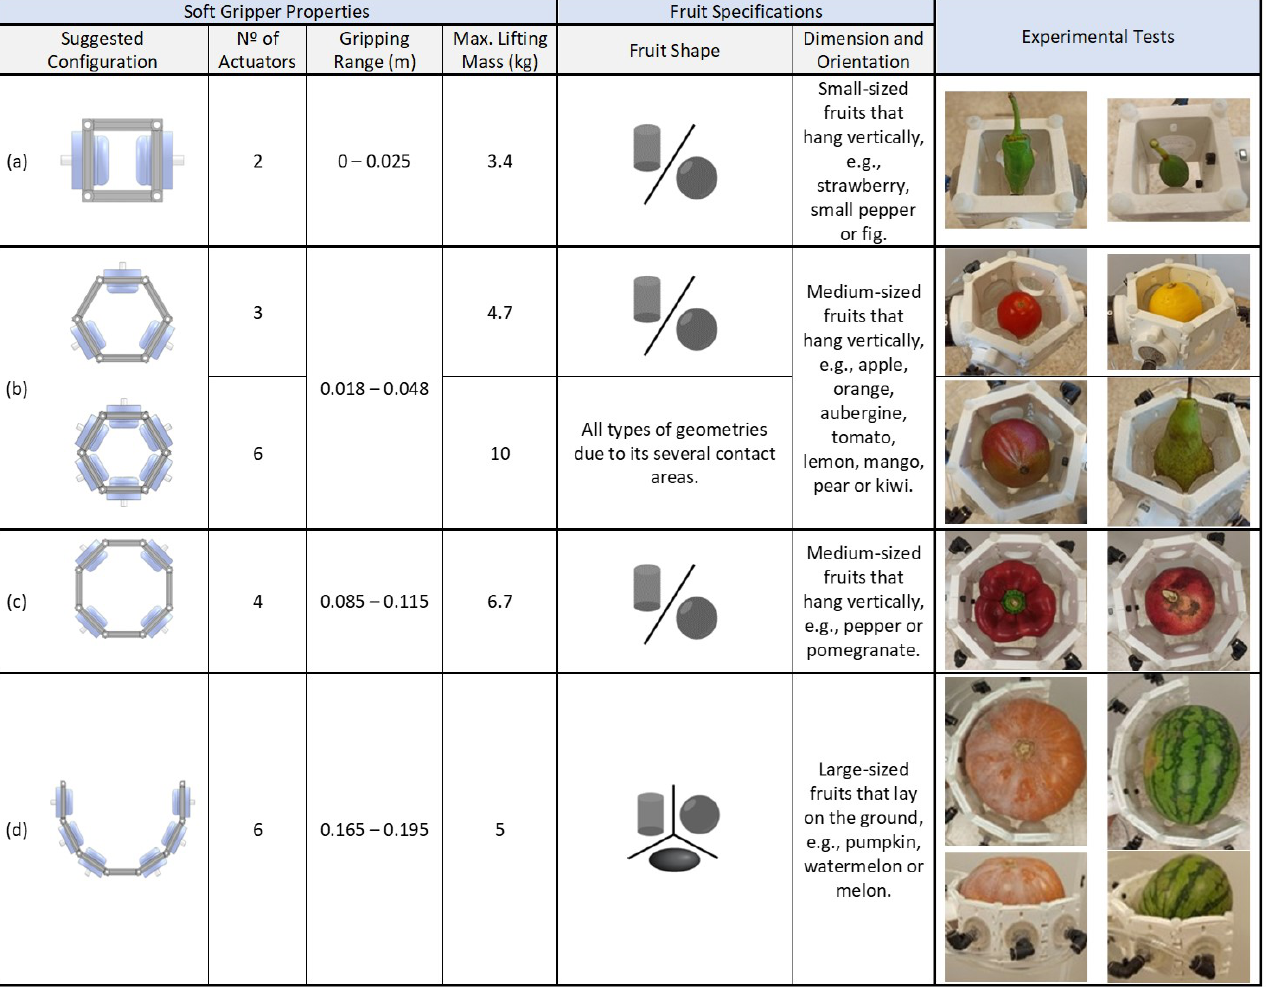
Figure 16. Preferred gripper configuration based on fruit type: ( a ) square configuration (two soft actuators); ( b ) hexagonal configuration (three and six soft actuators); ( c ) octagonal configuration (four soft actuators); and ( d ) open configuration (six soft